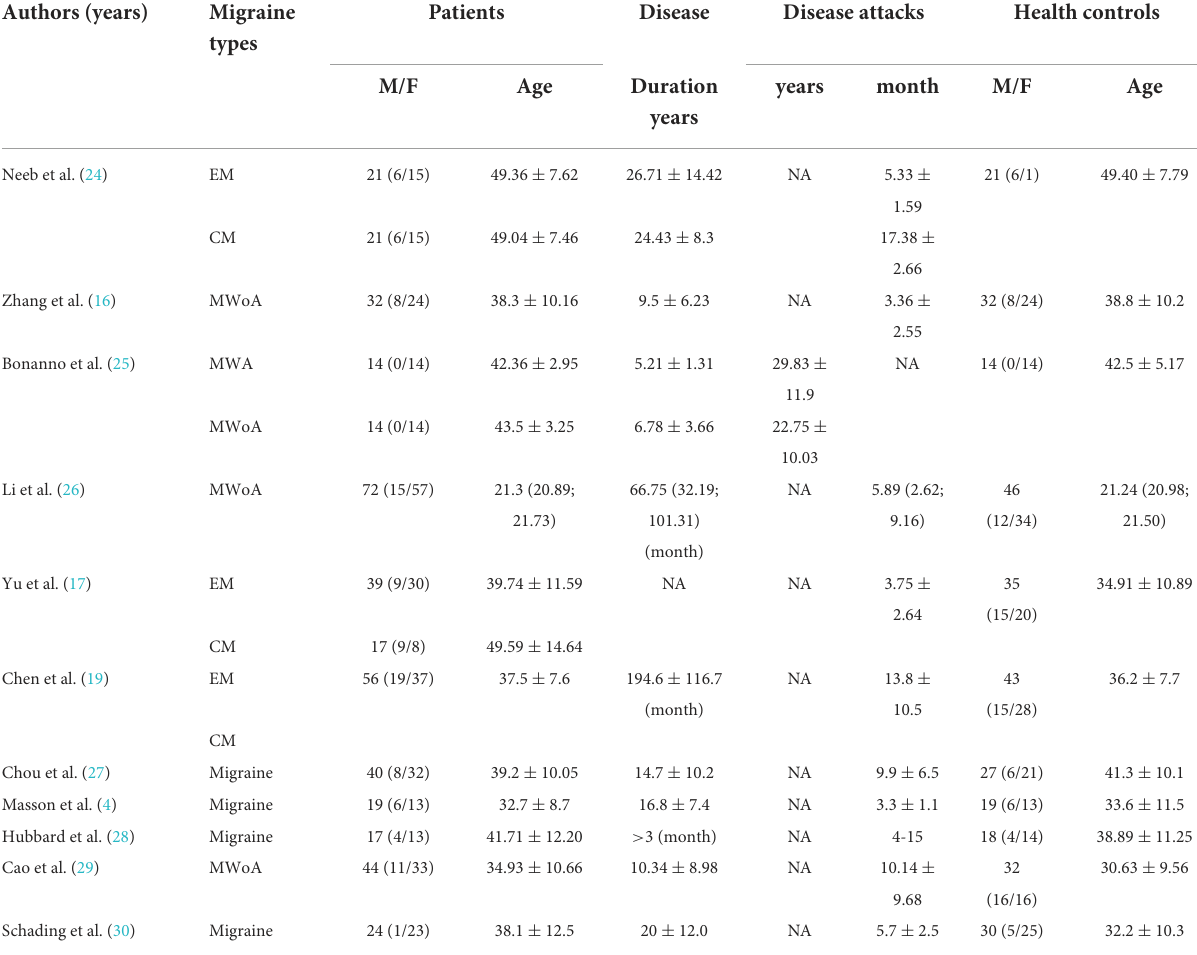
TABLE 1 Demographic and clinical characteristics of migraine in the VBM